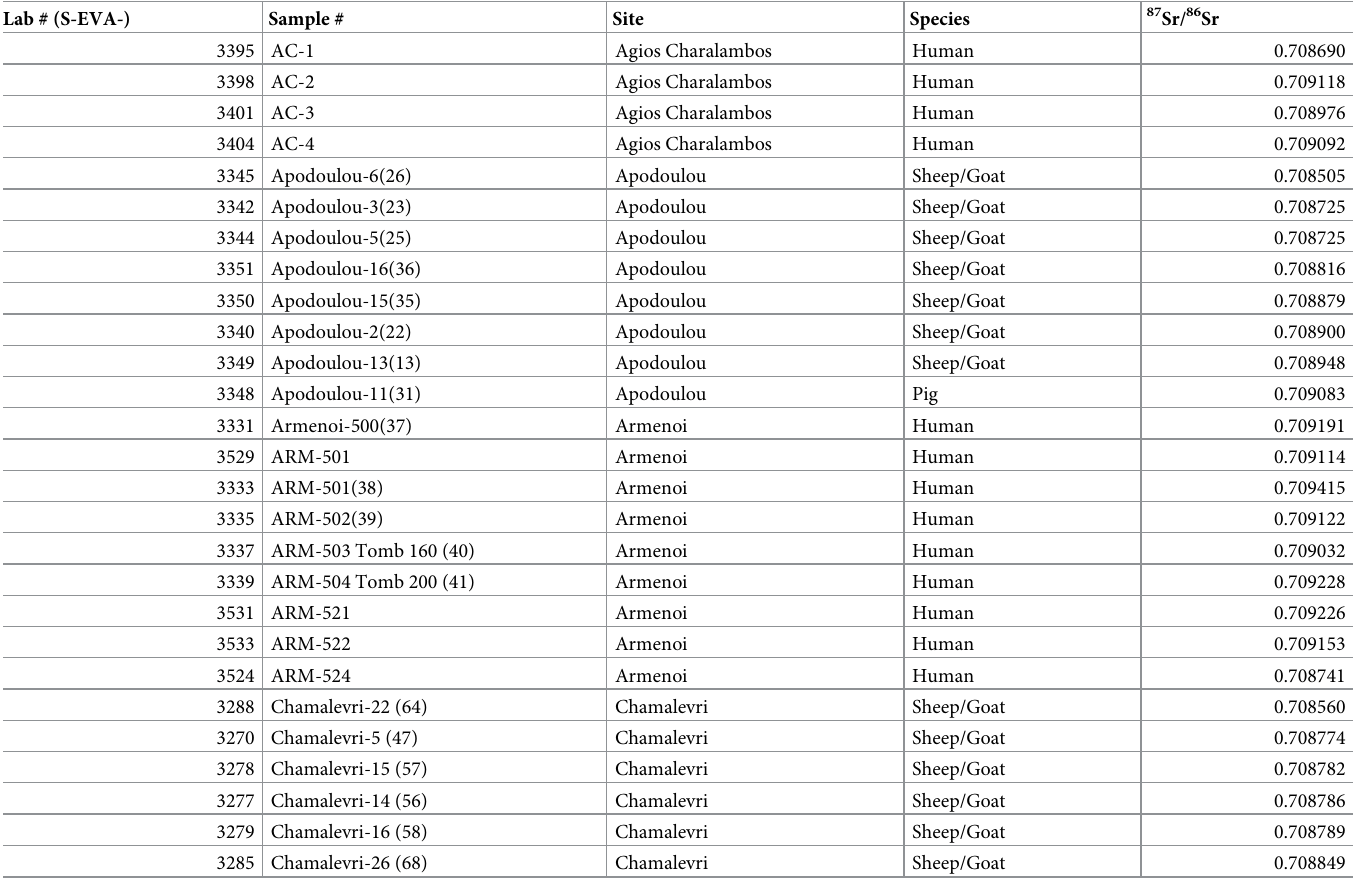
Table 5. Table of the strontium isotope data from human and faunal enamel from the study sites. Lab #